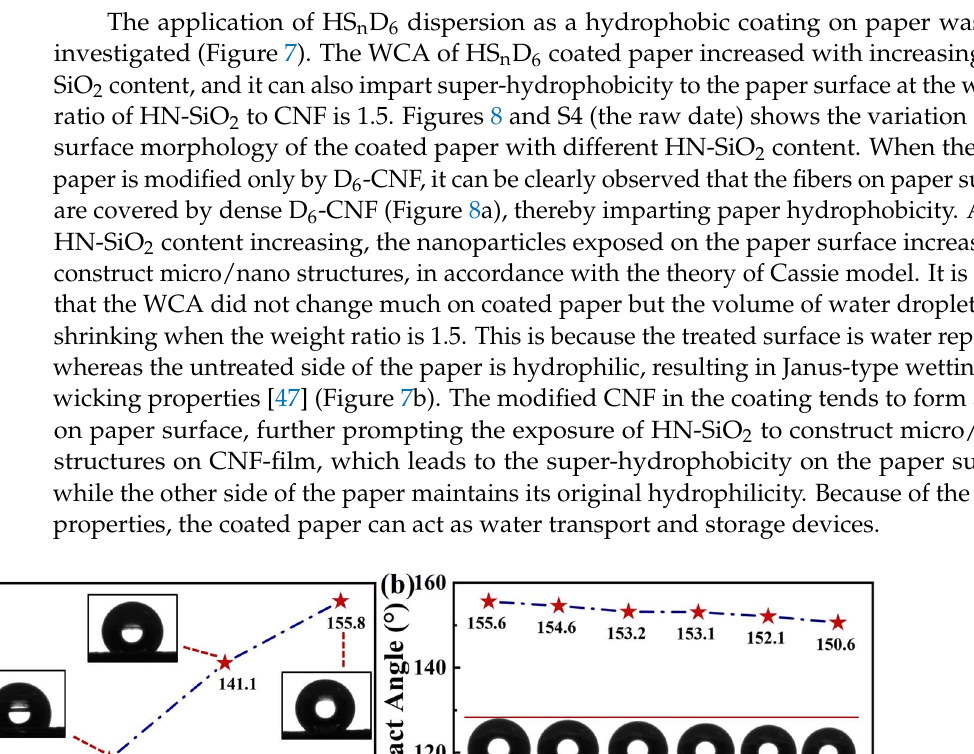
Figure 8. The SEM images of ( a ) HS 0 D 6 , ( b ) HS 50 D 6 , ( c ) HS 100 D 6 , and ( d ) HS 150 D 6 coated paper.